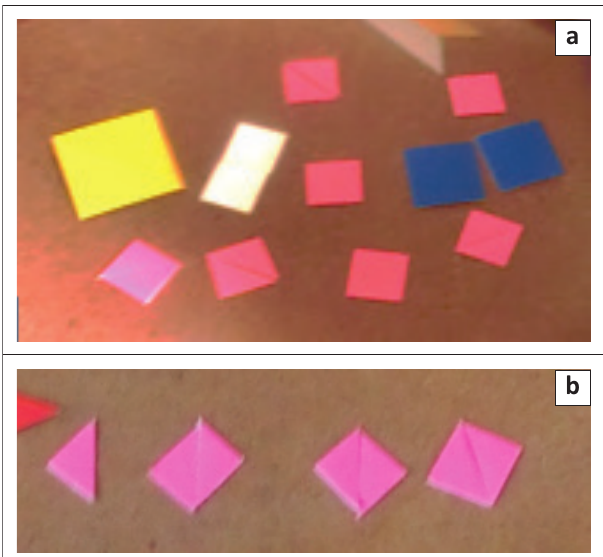
FIGURE 5: Squares that children produced in the second